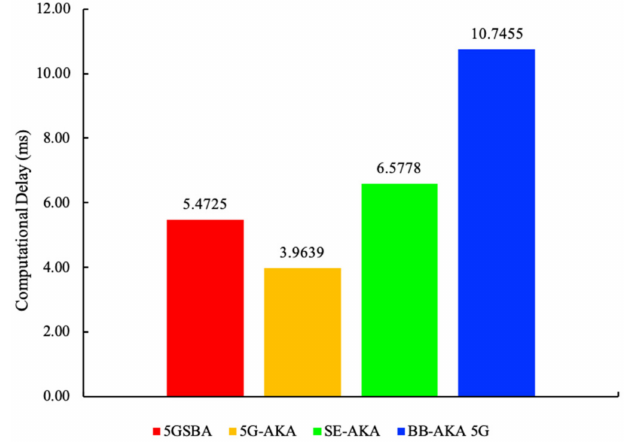
Figure 5. Experimental total computational